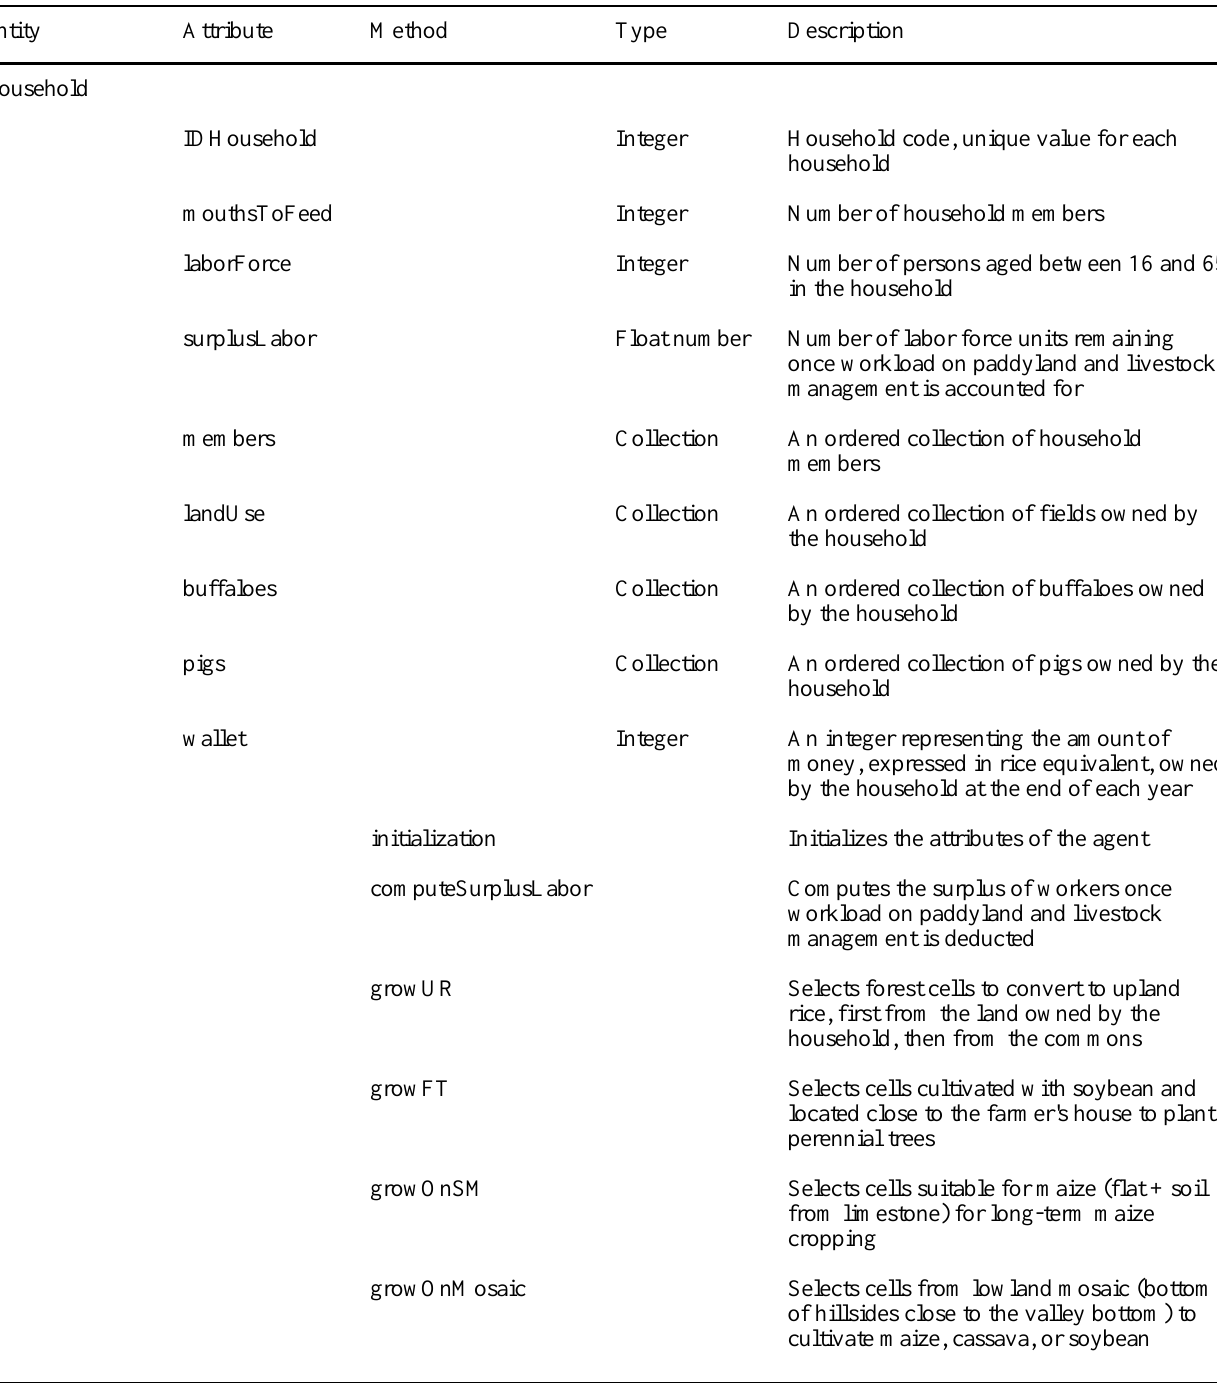
Table A1-1. Description of the different entities of the SAMBA-GIS